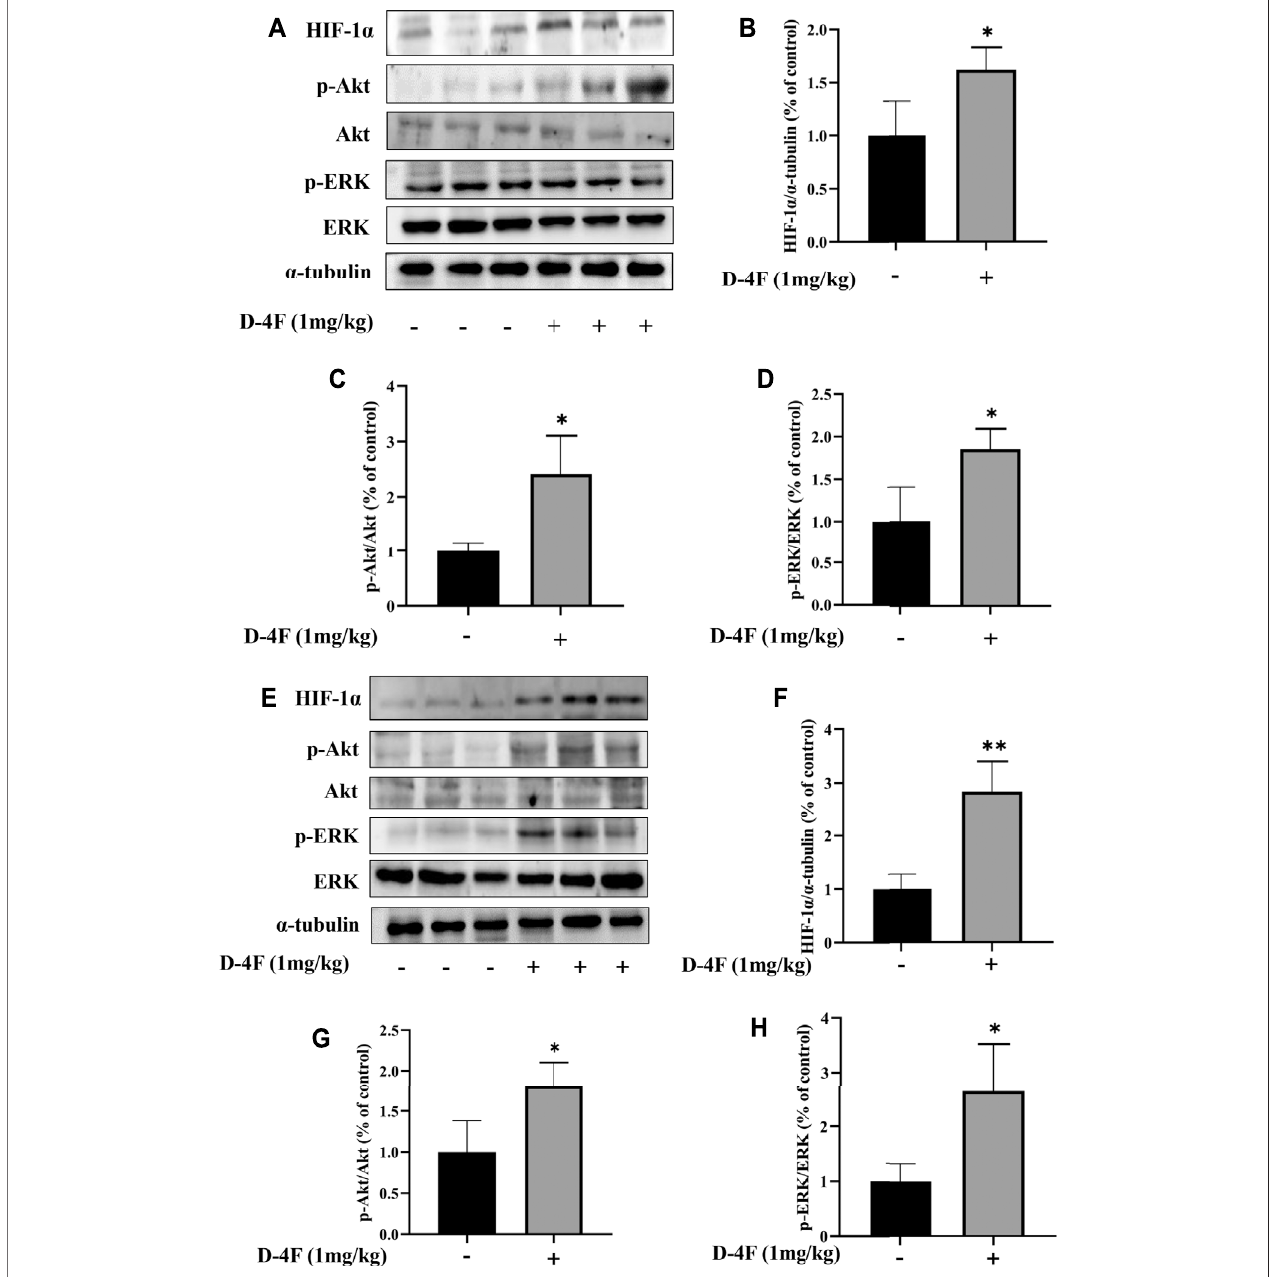
FIGURE 2 | D-4F upregulates protein levels of HIF-1 α , p-Akt, and p-ERK in mice. (A – D) Abdominal aorta. (E – H) Inferior vena cava. Mice were treated with or without D-4F at 1 mg/kg/day for 9 days, n (cid:1) 6, unpaired t -test, * p < 0.05, ** p < 0.01, compared with the group without the addition of